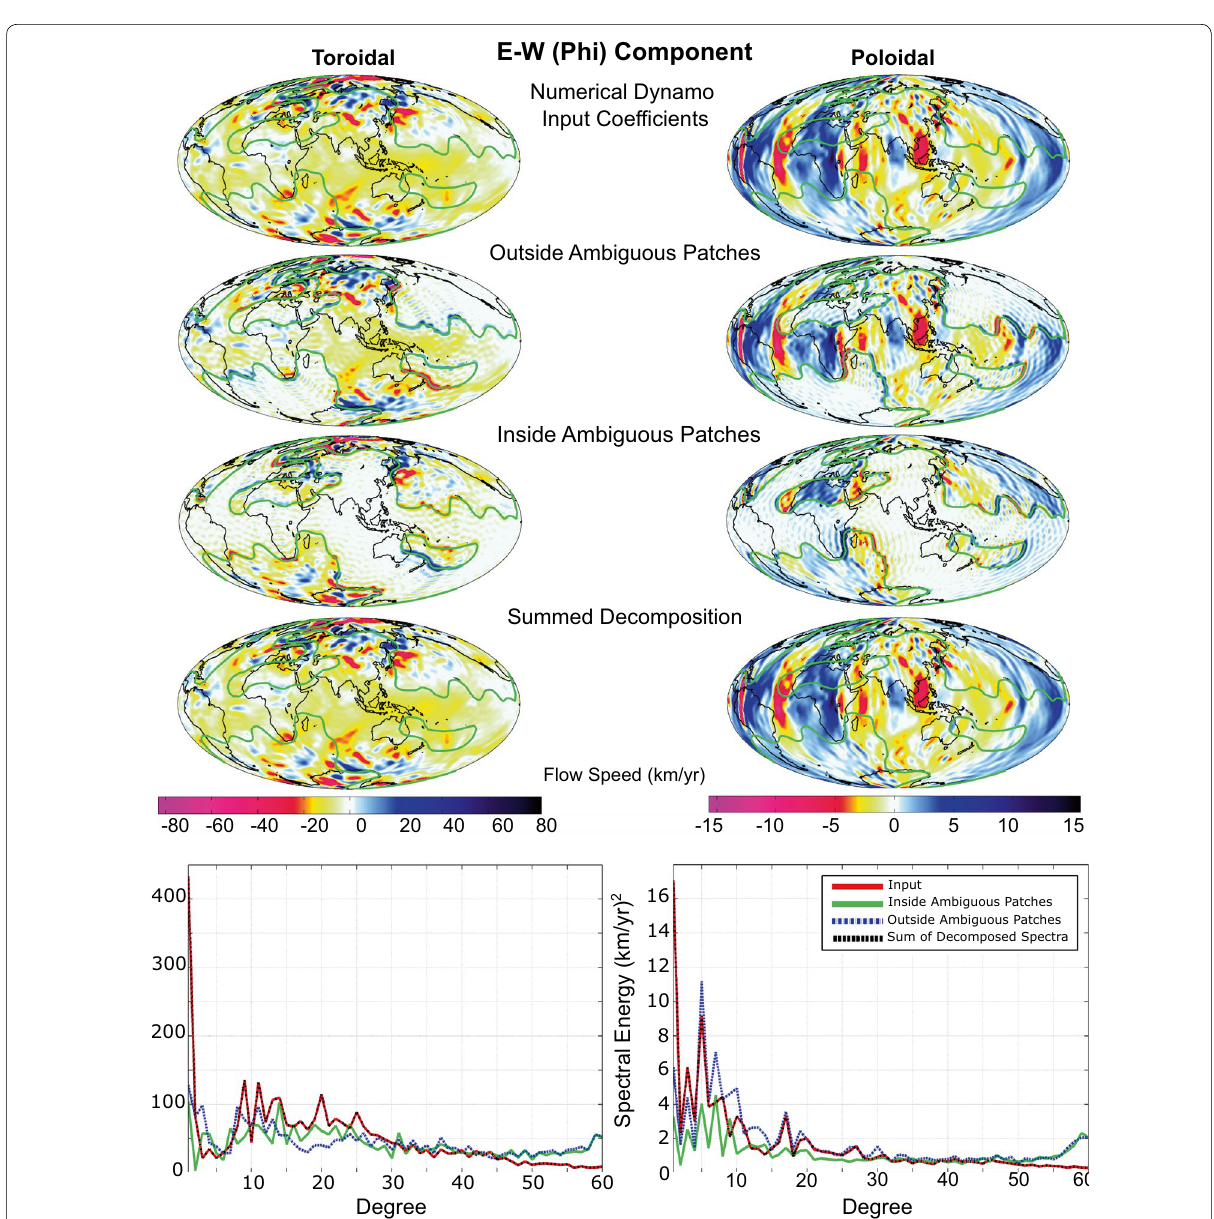
Fig. 4 Decomposition of the numerical dynamo flow simulation in eastward direction ( u φ component). Decomposition of a snapshot flow from a numerical model with coefficients up to degree 60 (3721 coefficients) using the Shannon number ( K ambiguous